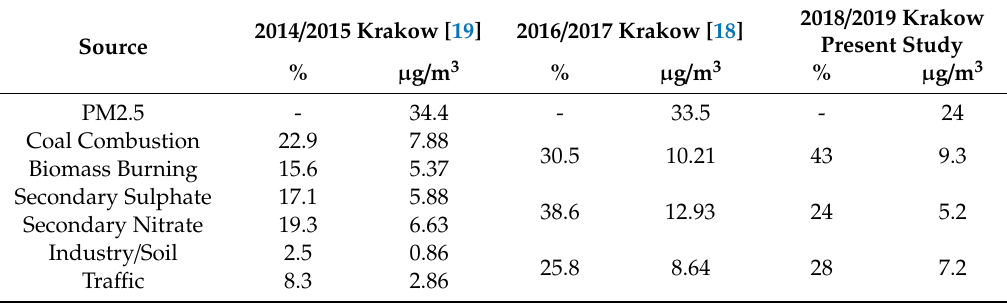
Table 2. Comparative results of the source contributions to PM2.5.